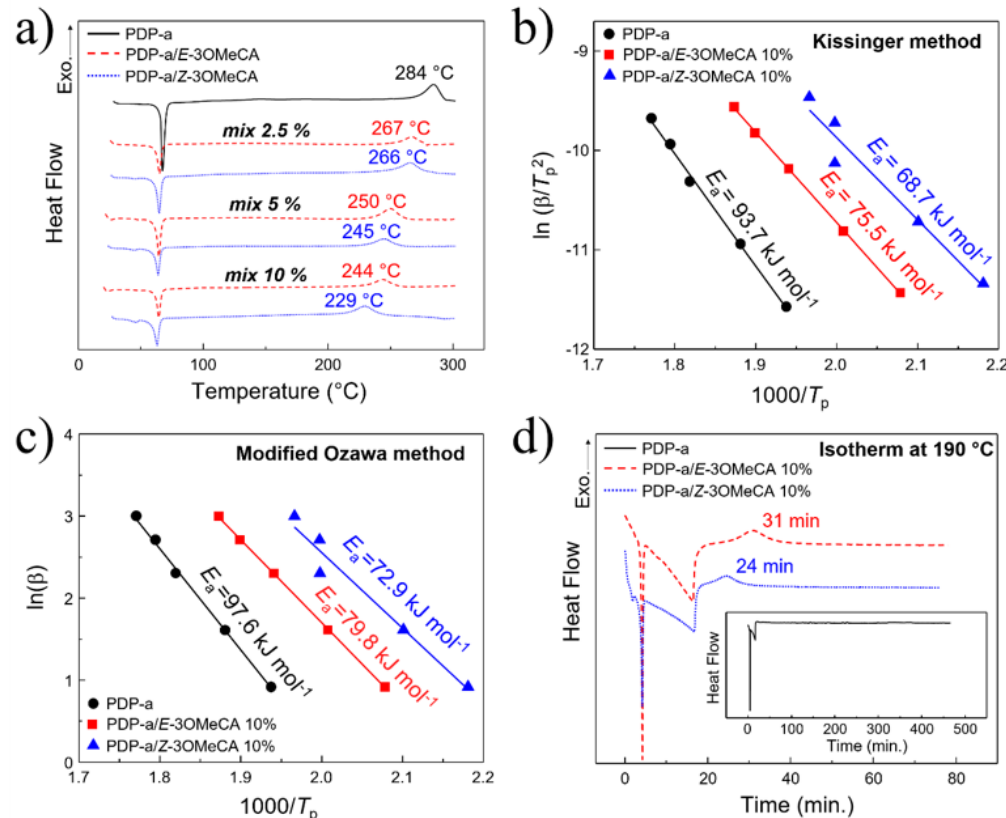
Figure 3. ( a ) DSC thermograms of PDP-a and PDP-a/catalyst mixtures at different ratios. Plots generated following the Kissinger ( b ) and modified Ozawa ( c ) methods for calculating the activation energy of catalyzed and uncatalyzed polymerization reactions. ( d ) Isothermal DSC thermograms at 190 °C for catalyzed and uncatalyzed (inset) polymerizations of PDP-a.